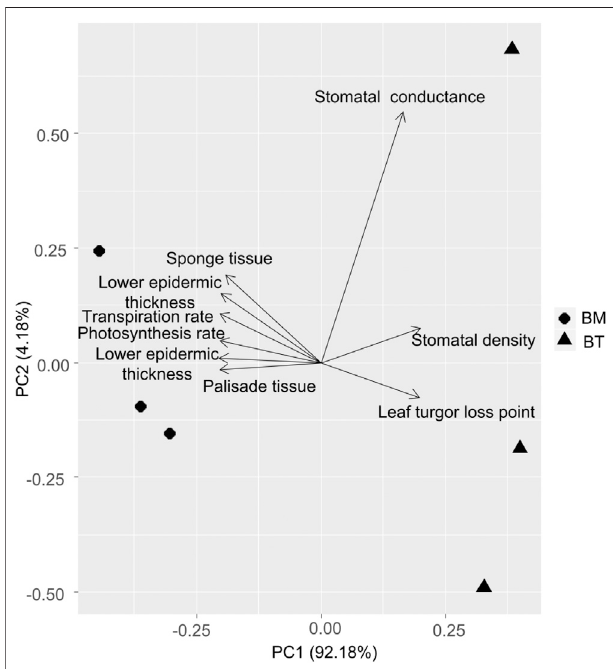
FIGURE 4 | Principal component analysis (PCA) of the nine functional traits between Bombax ceiba (BM) and Bridelia tomentosa (BT). Diamonds and triangles represent BM and BT respectively.